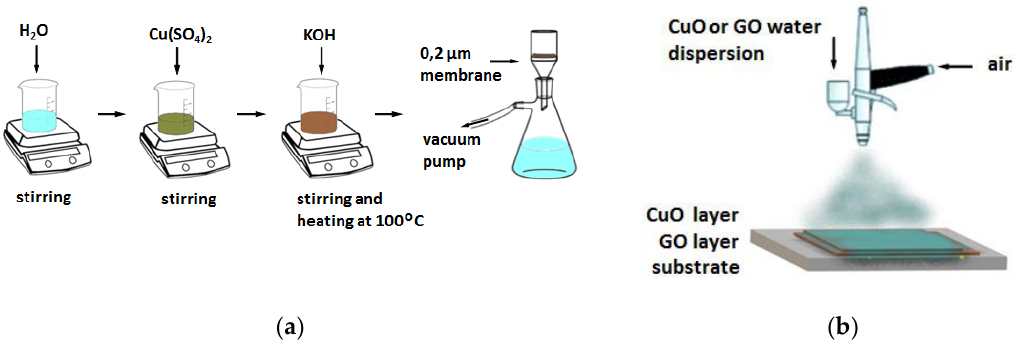
Figure 1. ( a ) Schematic of the preparation process of CuO and ( b ) deposition of GO/CuO multilayer by spraying. by